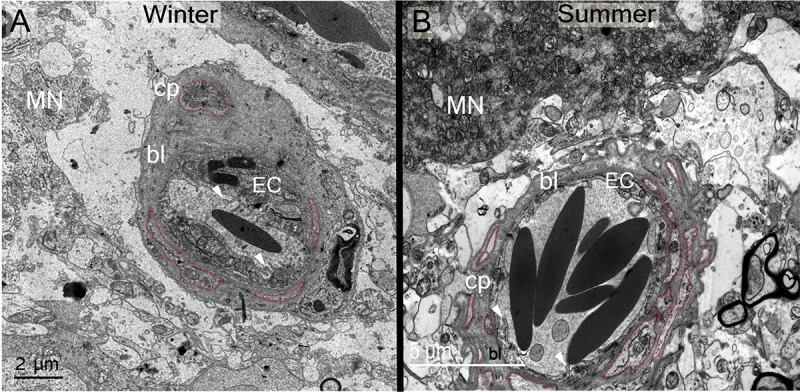
Electron micrographs showing ultrastructural differences in capillary (cp) basal lamina (bl) between winter (A) and summer (B). Note the differences in thickness and fenestration (outlined in pink). Note differences between seasons in cytoplasmic expansions (arrowheads) and thickness of endothelial cells (EC).